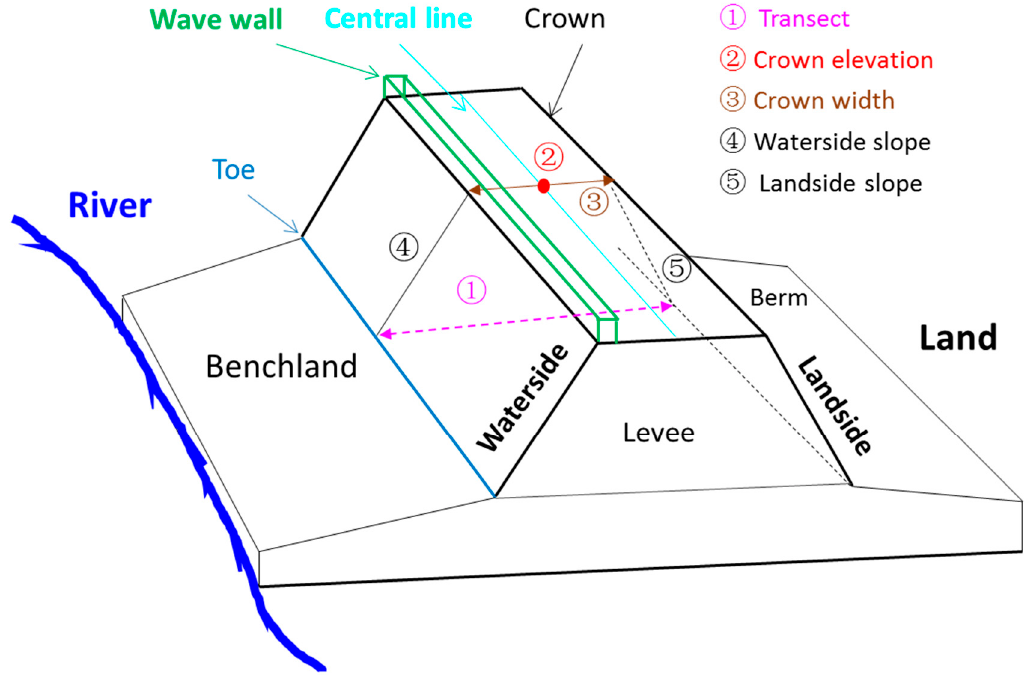
Figure 2. The sketch of the levee elements.